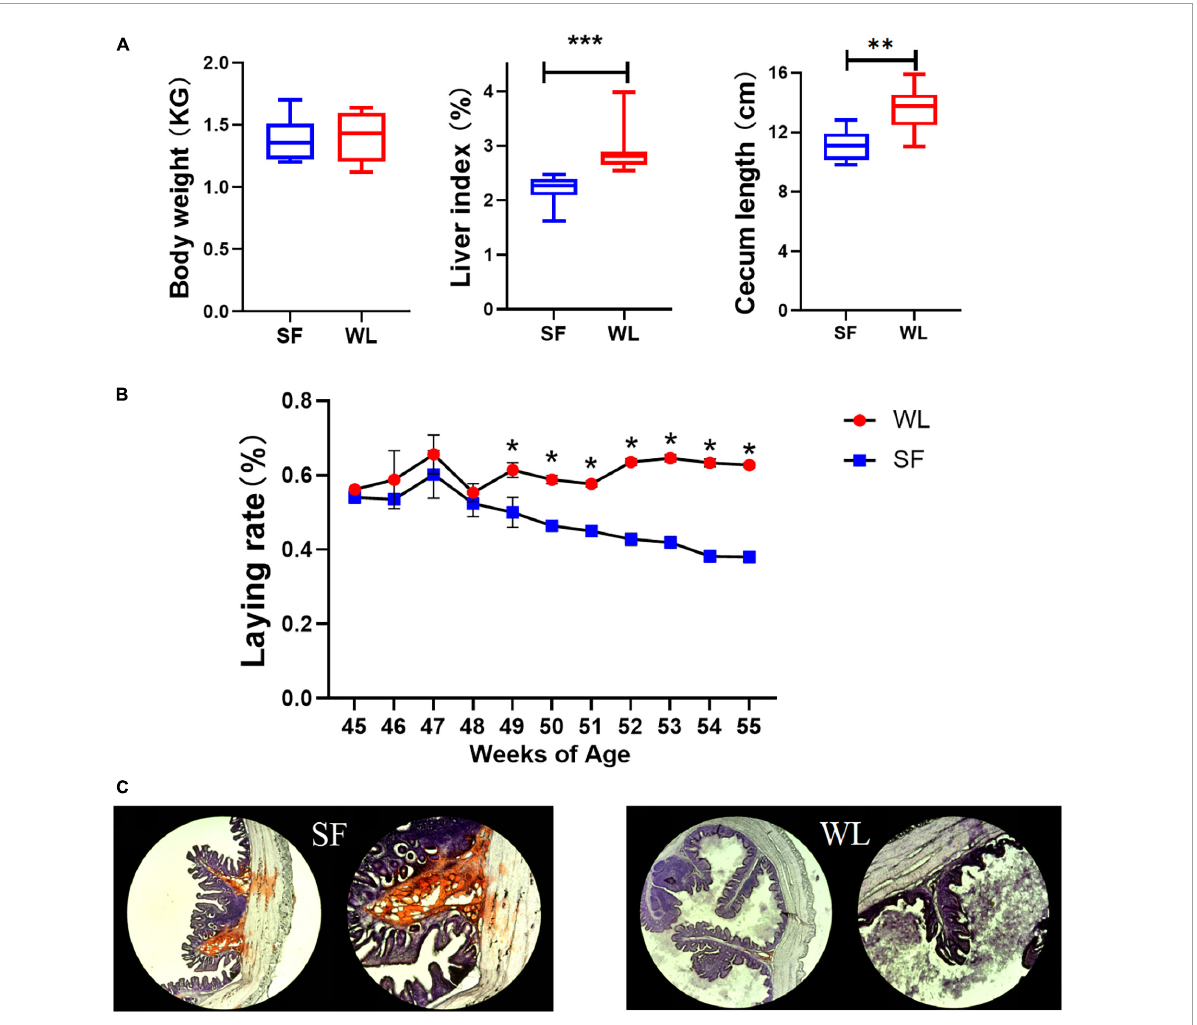
FIGURE1 Phenotypic index and oil red O staining. (A) Comparison of WL and SF in weight, liver index and cecum length. (B) Laying rate of SF and WL flock from 45 to 55-week-old. (C) Histological observation of WL and SF cecum after oil red O staining. Asterisk coding is indicated in the * P < 0.05; ∗∗ P < 0.01; *** P <